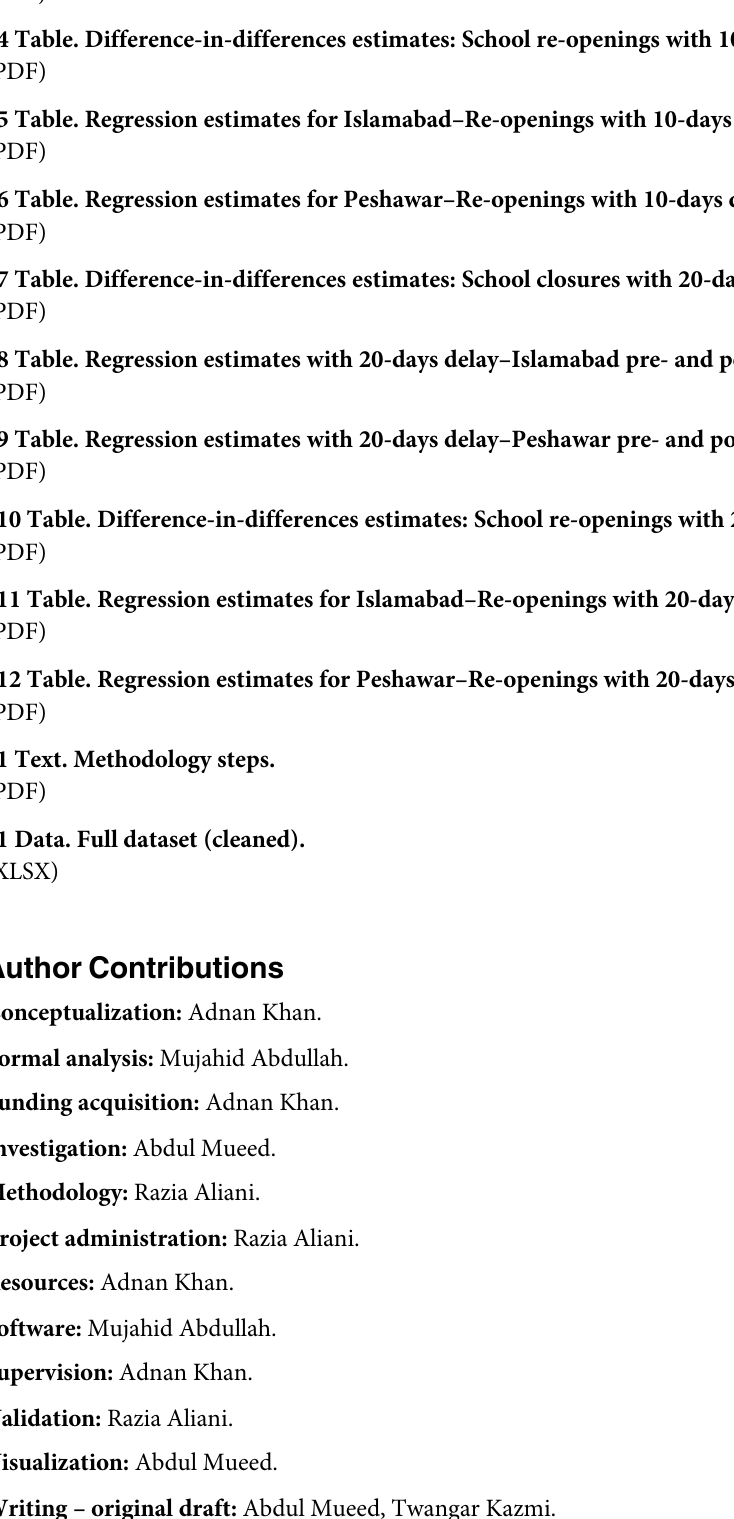
S3 Table. Regression estimates with 10-days delay–Peshawar pre- and post-closure. S4 Table. Difference-in-differences estimates: School re-openings with 10-days delay. S5 Table. Regression estimates for Islamabad–Re-openings with 10-days delay. S6 Table. Regression estimates for Peshawar–Re-openings with 10-days delay. S7 Table. Difference-in-differences estimates: School closures with 20-days delay. S8 Table. Regression estimates with 20-days delay–Islamabad pre- and post-closure. S9 Table. Regression estimates with 20-days delay–Peshawar pre- and post-closure. S10 Table. Difference-in-differences estimates: School re-openings with 20-days delay. S11 Table. Regression estimates for Islamabad–Re-openings with 20-days delay. S12 Table. Regression estimates for Peshawar–Re-openings with 20-days delay.